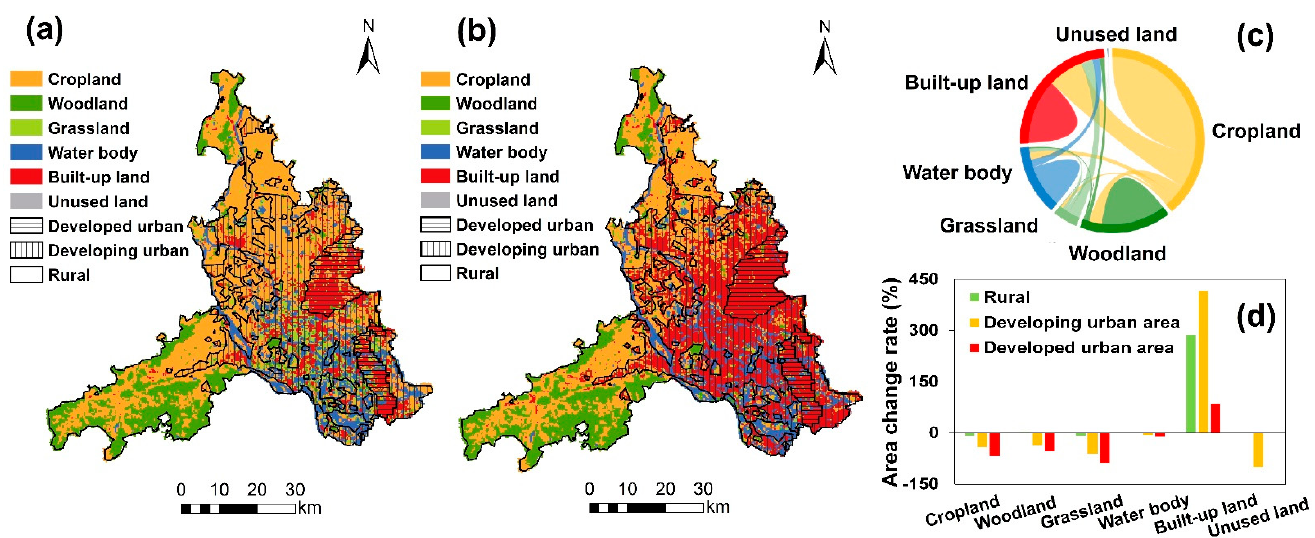
Figure 6. Land use and land cover change (LULC) in Foshan from 2000 to 2018. ( a ) LULC map in Foshan in 2000.( b ) LULC map in Foshan in 2018. ( c ) The data of the chord diagram comes from the transfer matrix of land use from 2000 to 2018. The area of the strip represents how much one type of land is transferred to another. ( d ) The rate of change of the area of each LULC under different urbanization levels.